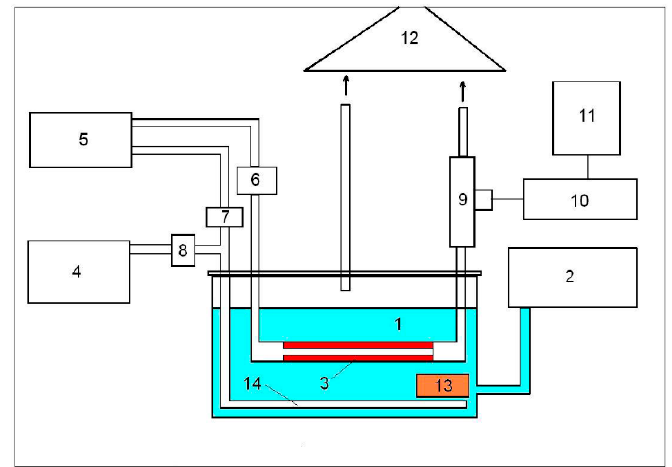
Figure 1. Scheme of setup used for the determination of concentration of volatile organics in water. cell with water; (2) can with distilled water; (3) tubular selective membrane; (4) cylinder with CH4; (5) pure air generator; (6–8) flow-meters; (9) methane sensor cell; (10),(11) ohmmeter and computer; (12) fume hood ; (13) water mixer; (14) air bubbler.